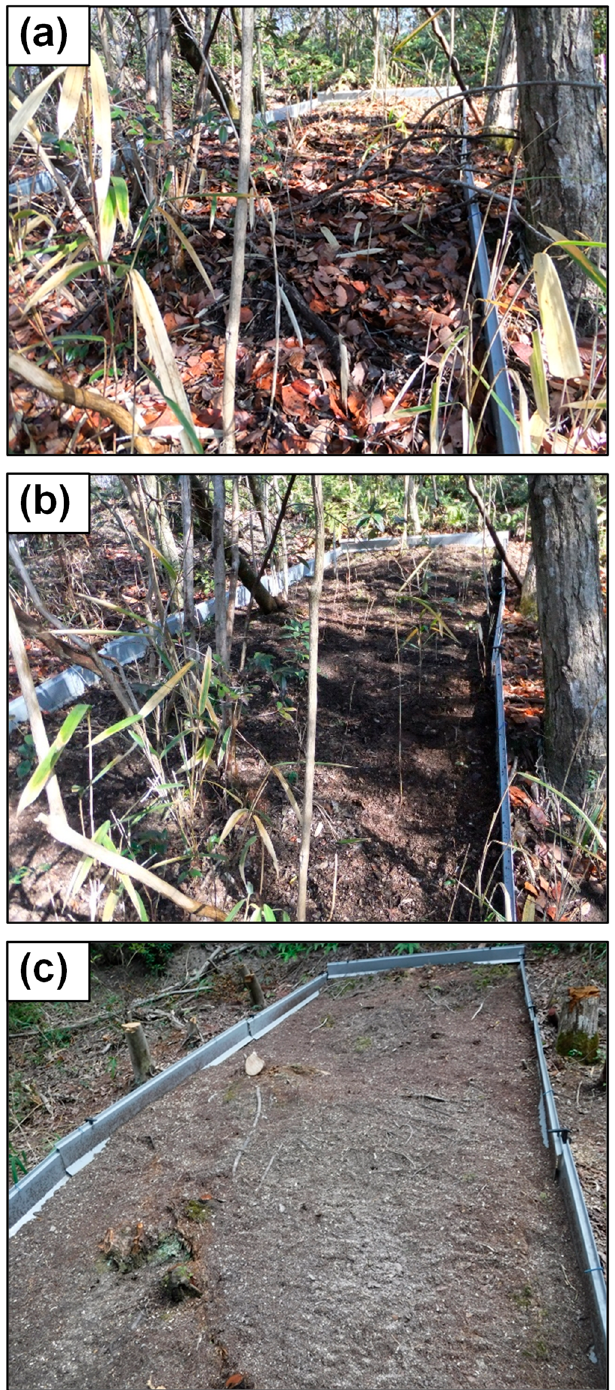
Figure 5. State of plot B in ( a ) no treatment (NT) phase; ( b ) litter removed before clearcutting (LRBC) phase; and ( c ) after clearcutting (AC) phase.